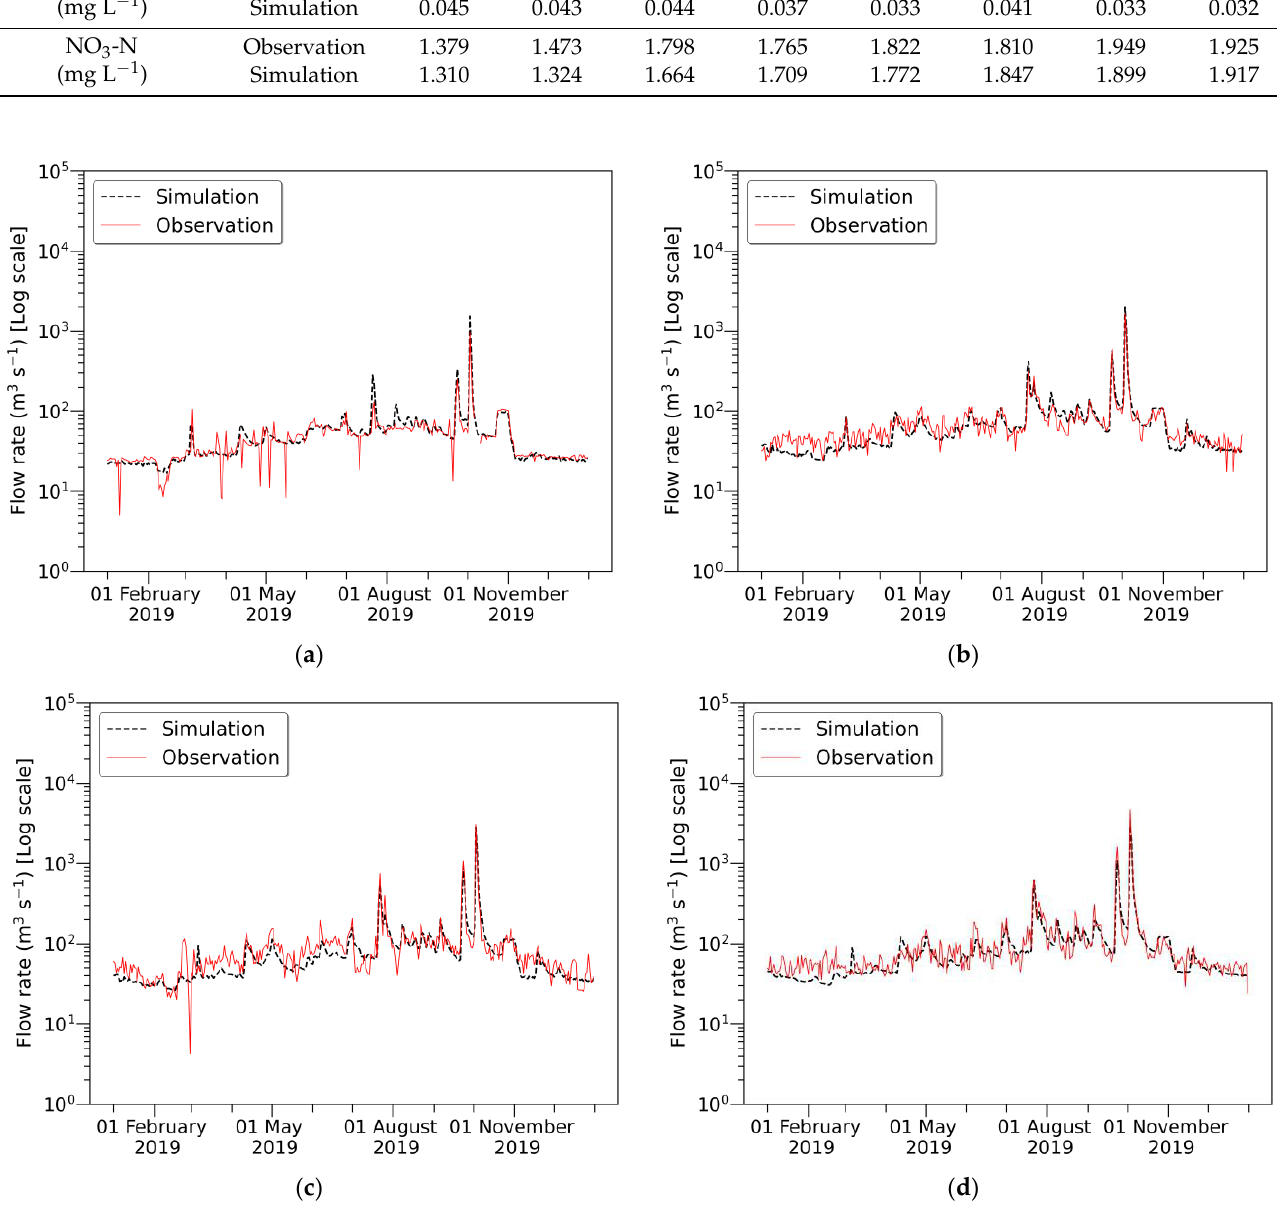
Figure 4. Hydrographs showing the difference between simulation and observation for